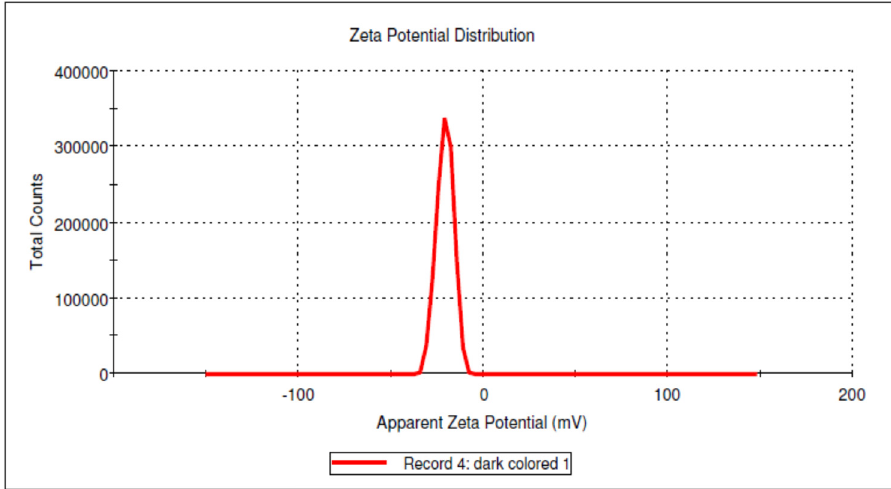
Figure 7: Zeta potential of Z. mays silk - fabricated